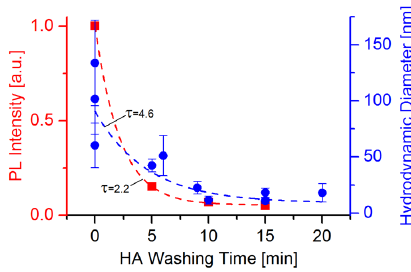
Figure 4. Red squares: Development of PL intensity over the HA washing time for CdSe QDs synthesized in hexadecylamine/trioctylphosphine oxide (HDA/TOPO) (100:3:2, 30 min at 300 °C). Blue dots: Respective development of the hydrodynamic diameter together with the standard deviation for CdSe QDs measured by dynamic light scattering (DLS). For both, the half-life τ in min is given for the respective fitted exponential decay.